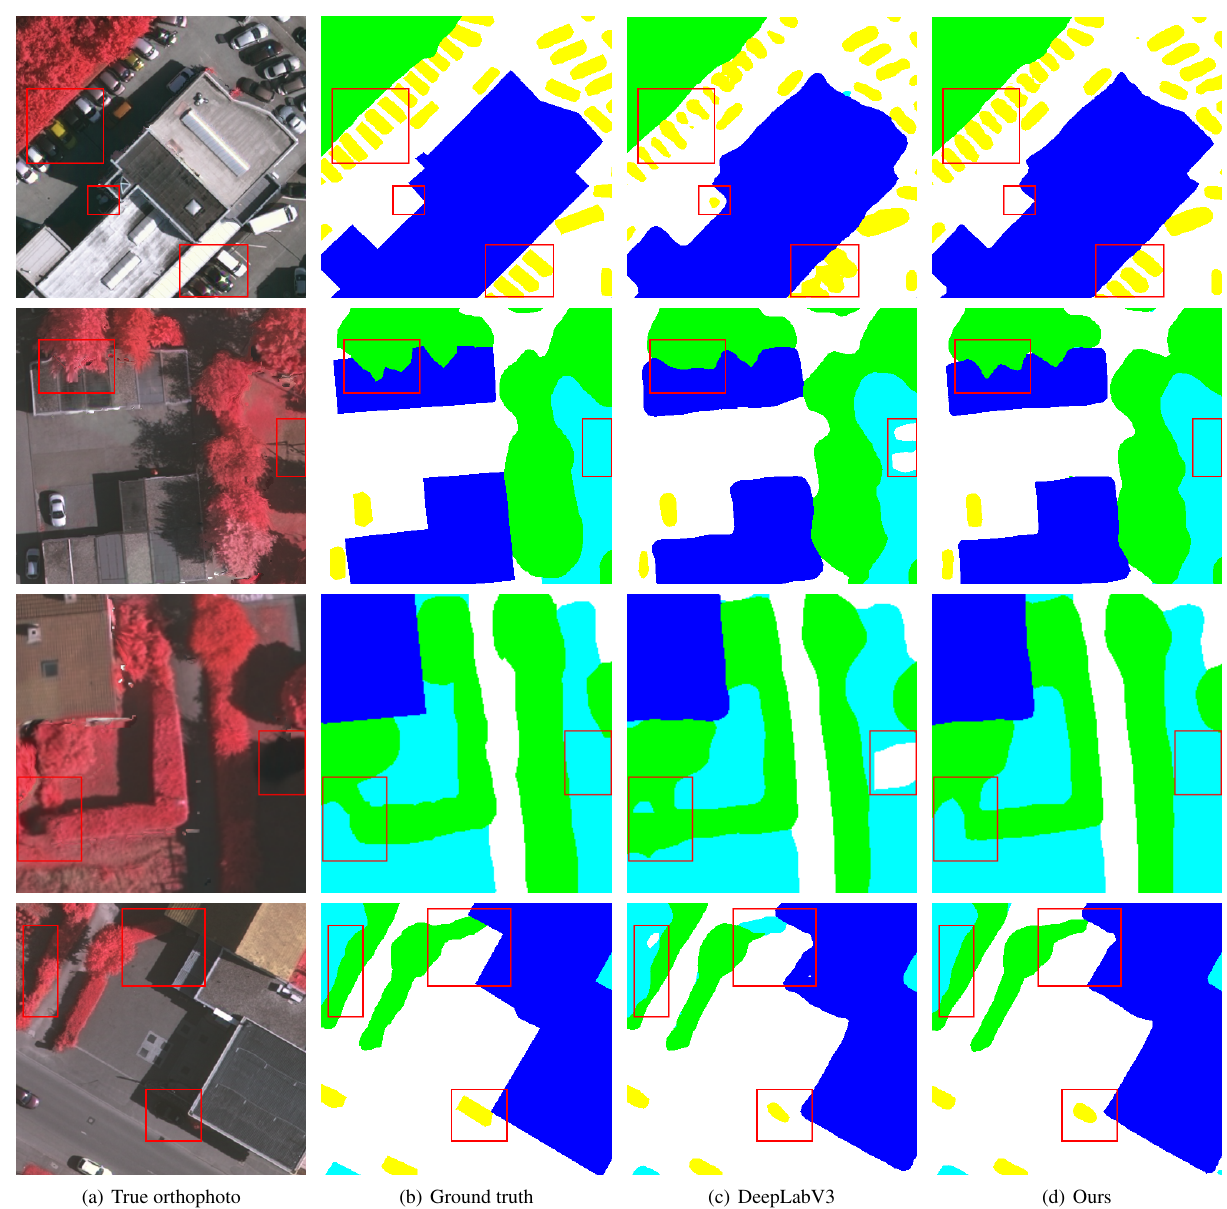
Figure 7. Visualization of the ground truth and the segmentation results achieved with the DeepLabV3 and our method. There is a significant improvement on small-sized objects and object